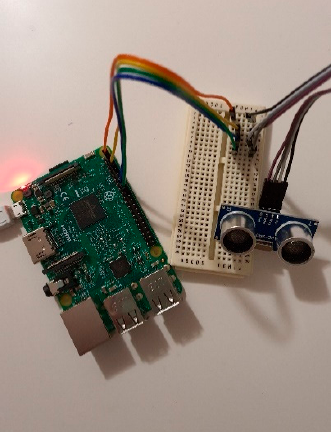
Figure 7. Prototype of Raspberry Pi and the water sensor connected with a breadboard.